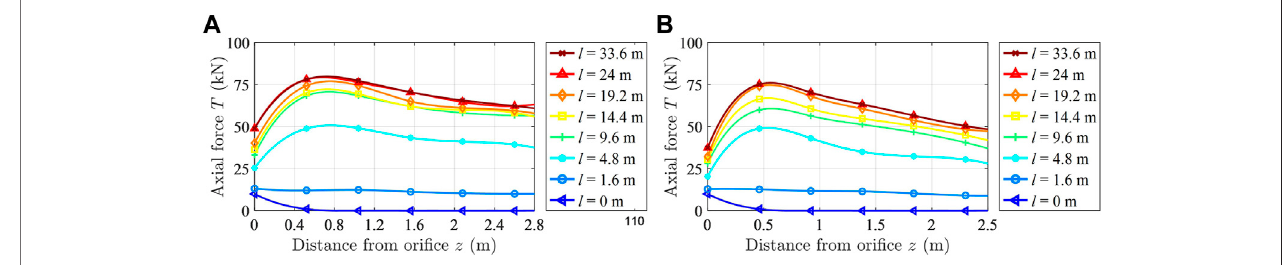
FIGURE12| Variationcurve oftheaxialforceofaforcemeasuringbolt: (A) Forcemeasuring anchorboltAinthemiddleoftheroofand (B) forcemeasuringanchor bolt B in the middle of the side.